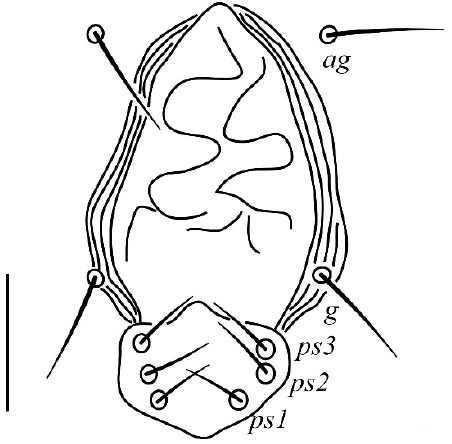
Figure 13. Neophyllobius fissus . Female. Genital and anal region. Scale bar: 20 μ m.